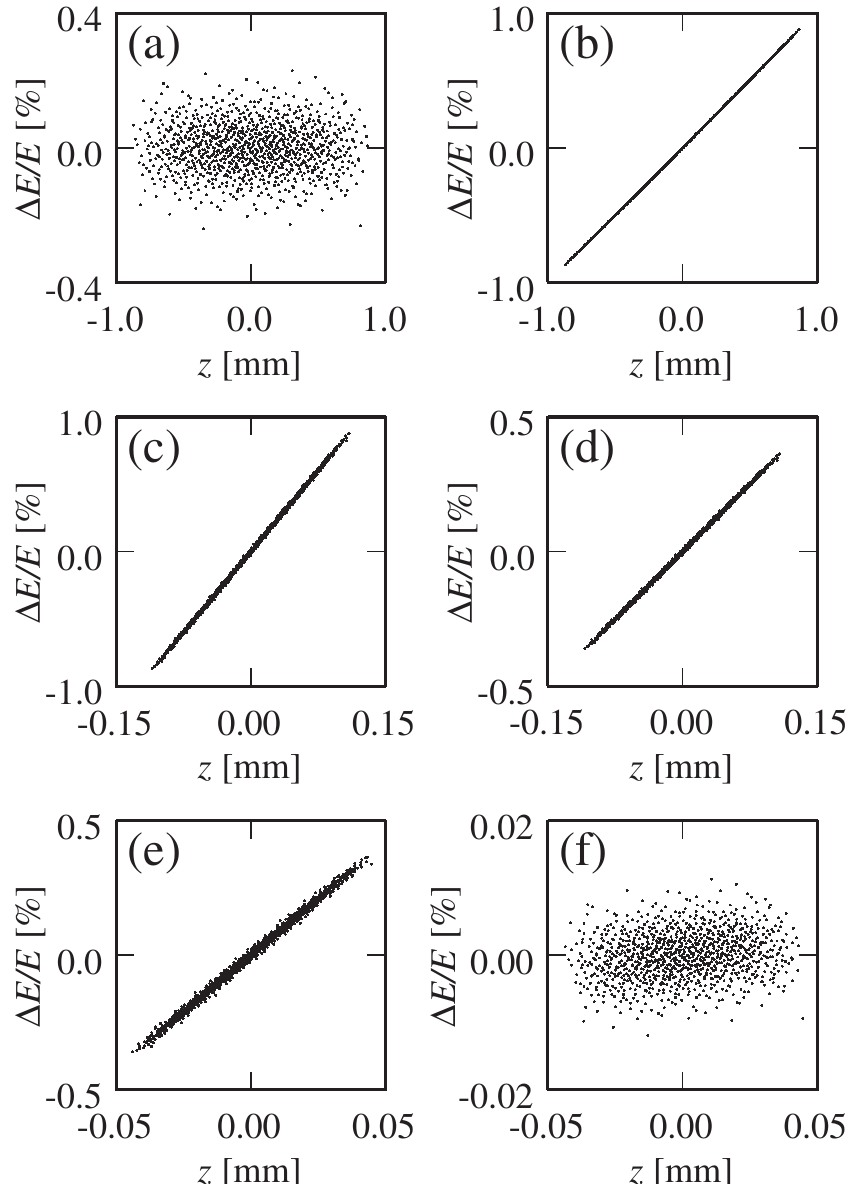
MODELING TWO-STAGE BUNCH COMPRESSION . .